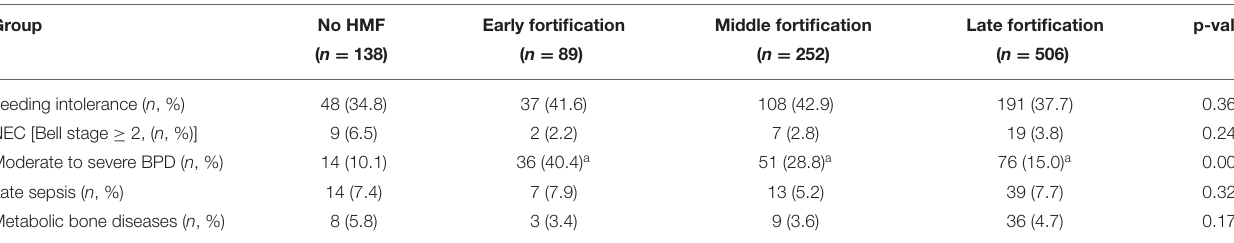
TABLE 2 | Comparison of complication